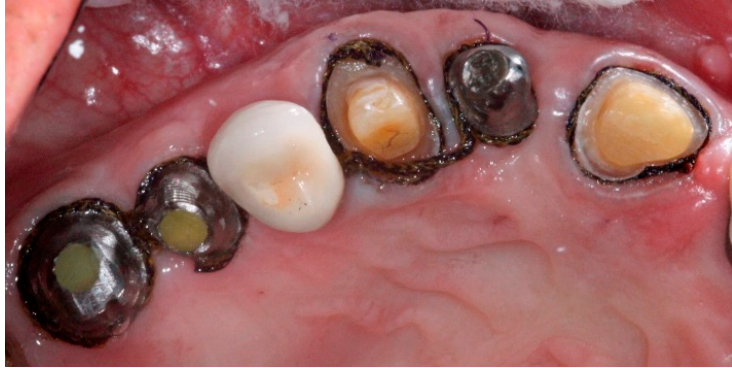
Figure 8. Abutment level impression as conventional crown and bridge impression technique.